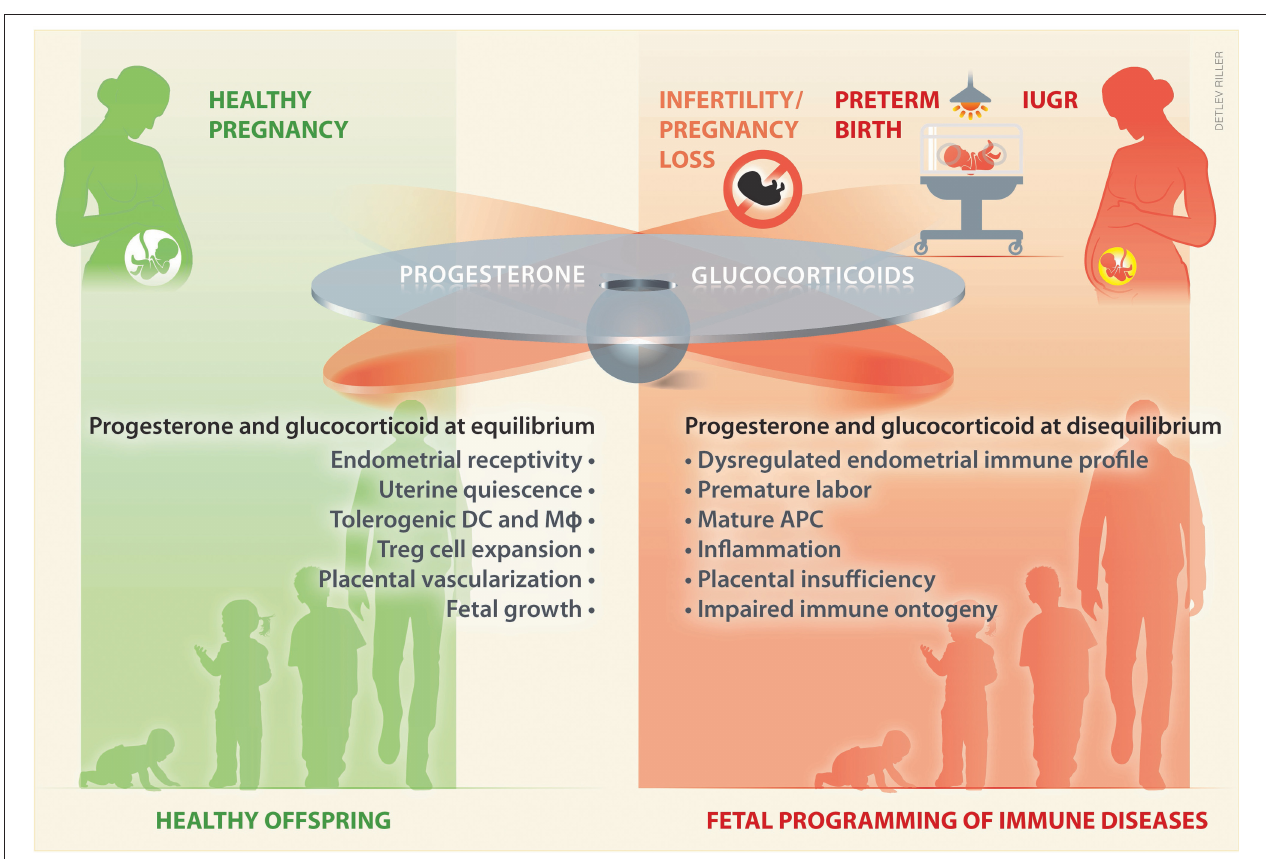
FIGURE 2 | During pregnancy a tight balance between glucocorticoids and progesterone may take place. An equilibrium between these hormones ensures adequate levels to sustain uterine receptivity and quiescence, as well as a tolerogenic immune profile, which pivotally promotes placental vascularization and a healthy fetal growth. In contrast, a disequilibrium in progesterone and/or glucocorticoids may fail to sustain pregnancy, and underlie an altered intrauterine immune profile, prone to inflammation, which leads to placental insufficiency and poor fetal growth. Such a disequilibrium may play an upstream role in women suffering from infertility or from pregnancy complications, such as early pregnancy loss, preterm birth, and IUGR. Impaired fetal growth and altered prenatal exposure to glucocorticoids influences the fetal immune ontogeny, which may result on fetal programming of immune disease in the offspring. DC, dendritic cells; M φ , macrophages; APC, antigen presenting cells; IUGR, intrauterine growth